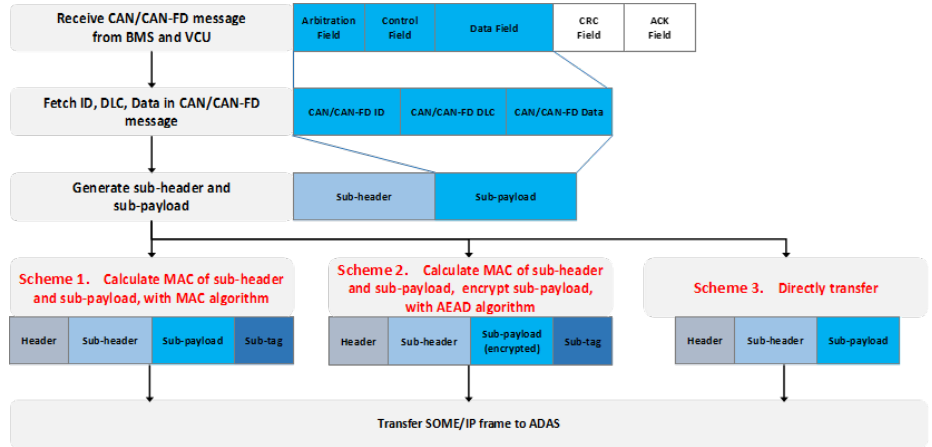
Figure 9. Security module flow chart and message composition at each stage.